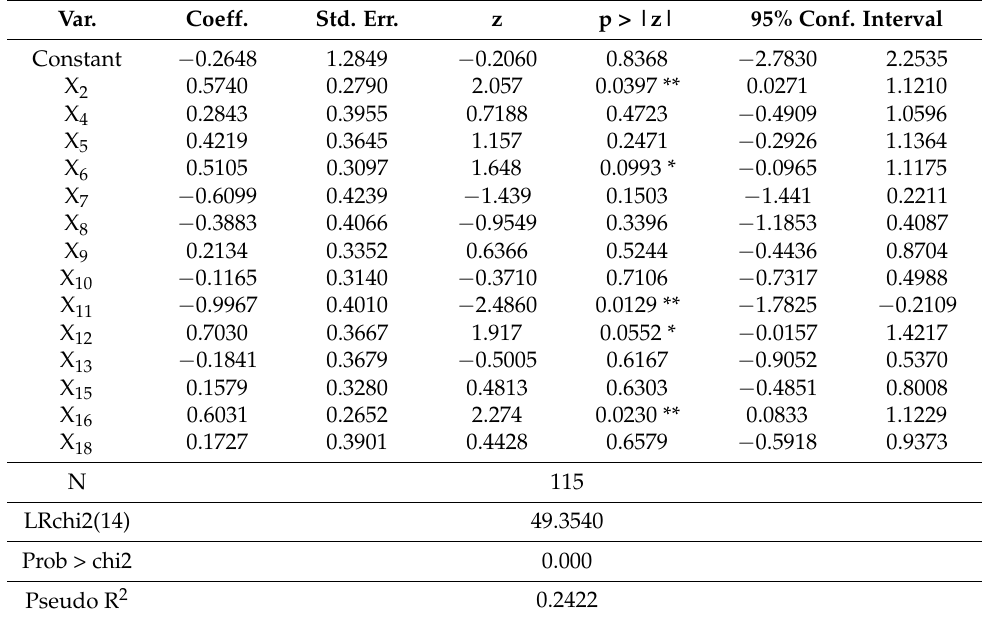
Table 3. Financial logit model for innovation activity. Var. Coeff.